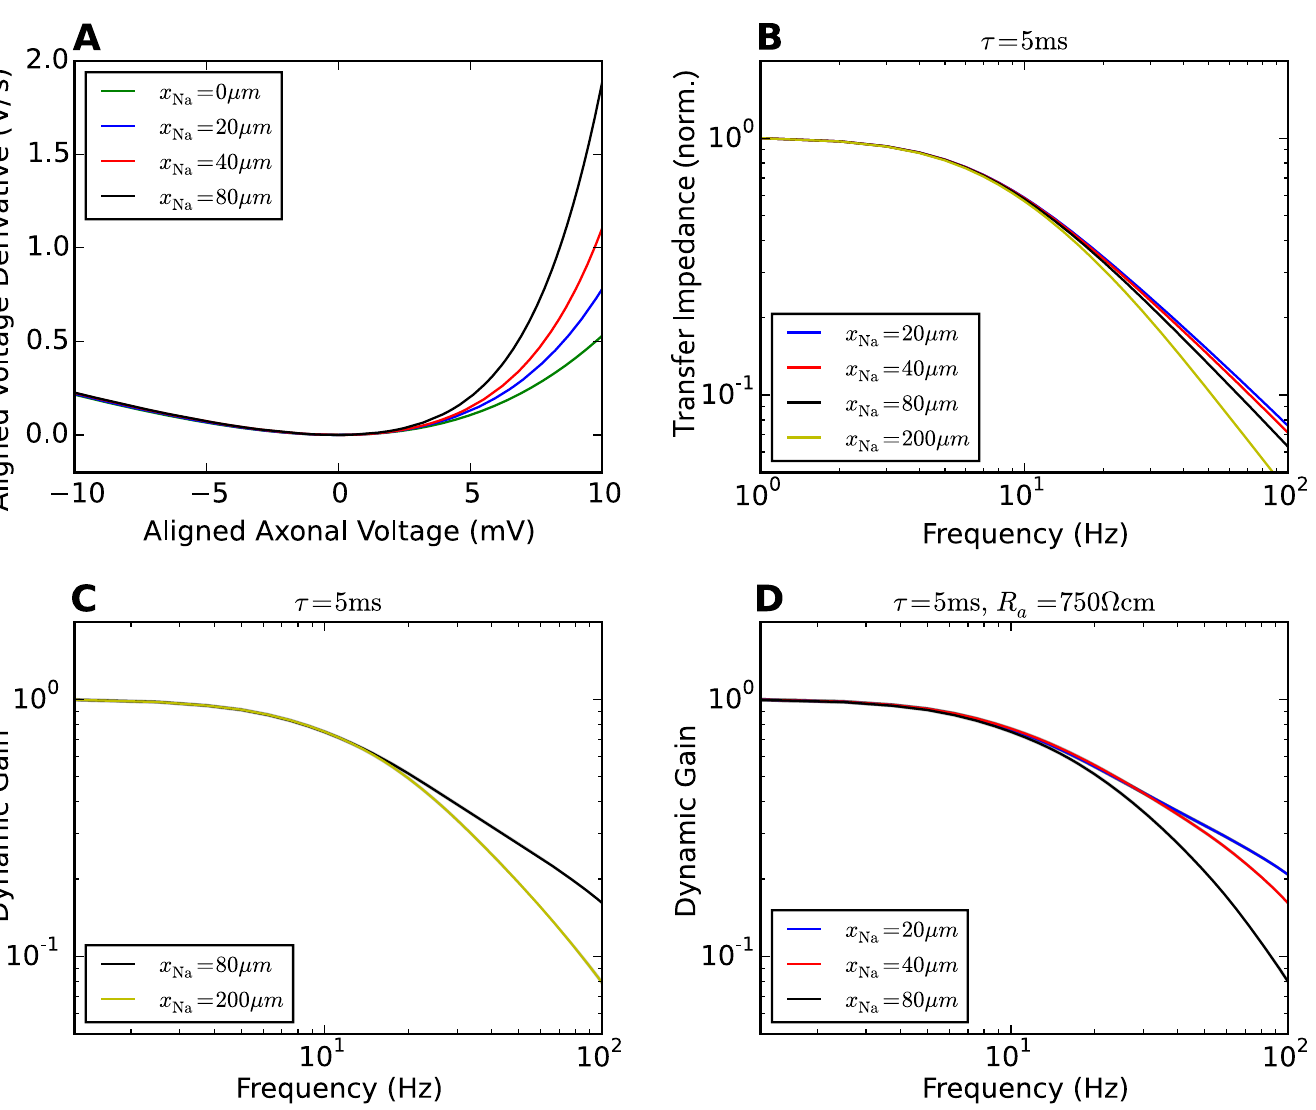
Fig 3. Impact of initiation site distance and transfer impedance on dynamic gain. A Phase plots for the AP waveforms at the initiation site. Moving the initiation site away from the soma reduces the lateral current during AP generation, leading to a more rapid initiation dynamics. The local minima of all curves are aligned at (0mV, 0mV/ms). The action potential waveforms are shown in S1 Fig. B Transfer impedance when the stimulus is transmitted from the soma to the AP initiation site. C Increasing x Na to 200 μ m decreases the high-frequency gain of the neuron model. D Increasing R to 750 O cm reduces the impact of initiation site distance on a dynamic gain (compare to Fig 2B). The transfer impedance effect dominates the dynamic gain. A larger x Na reduces the high-frequency